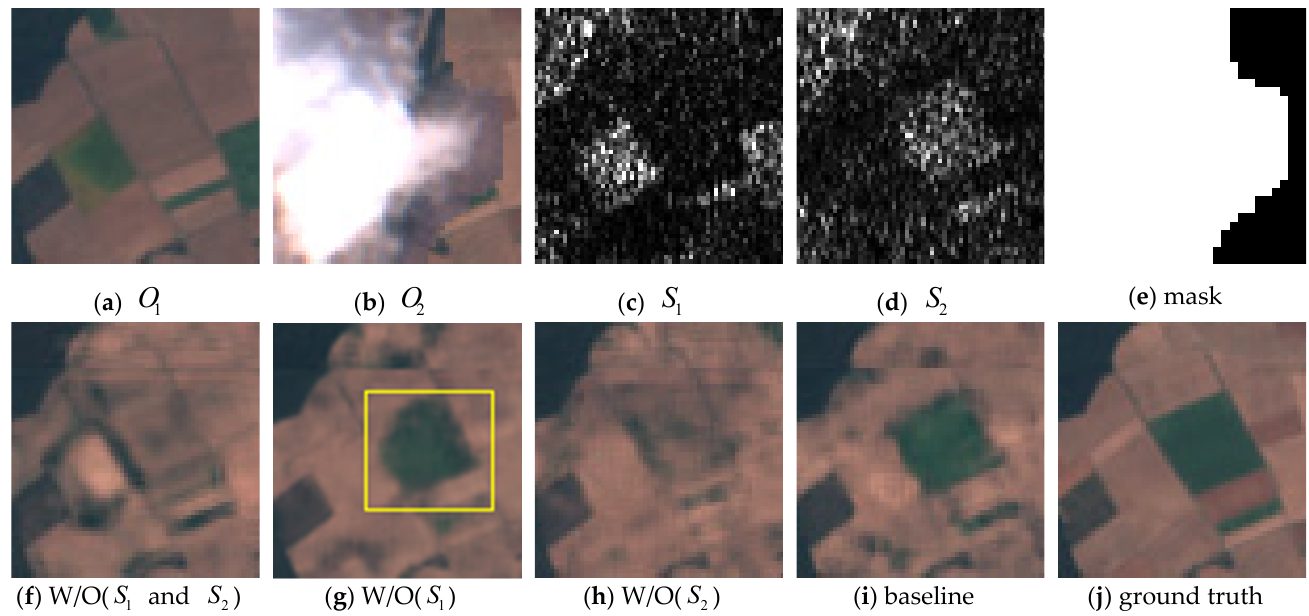
Figure 10. Magnified area from Figure 9. Every reference image contributes positively to the final result. Table 4. Quantitative evaluation of ablation models about reference